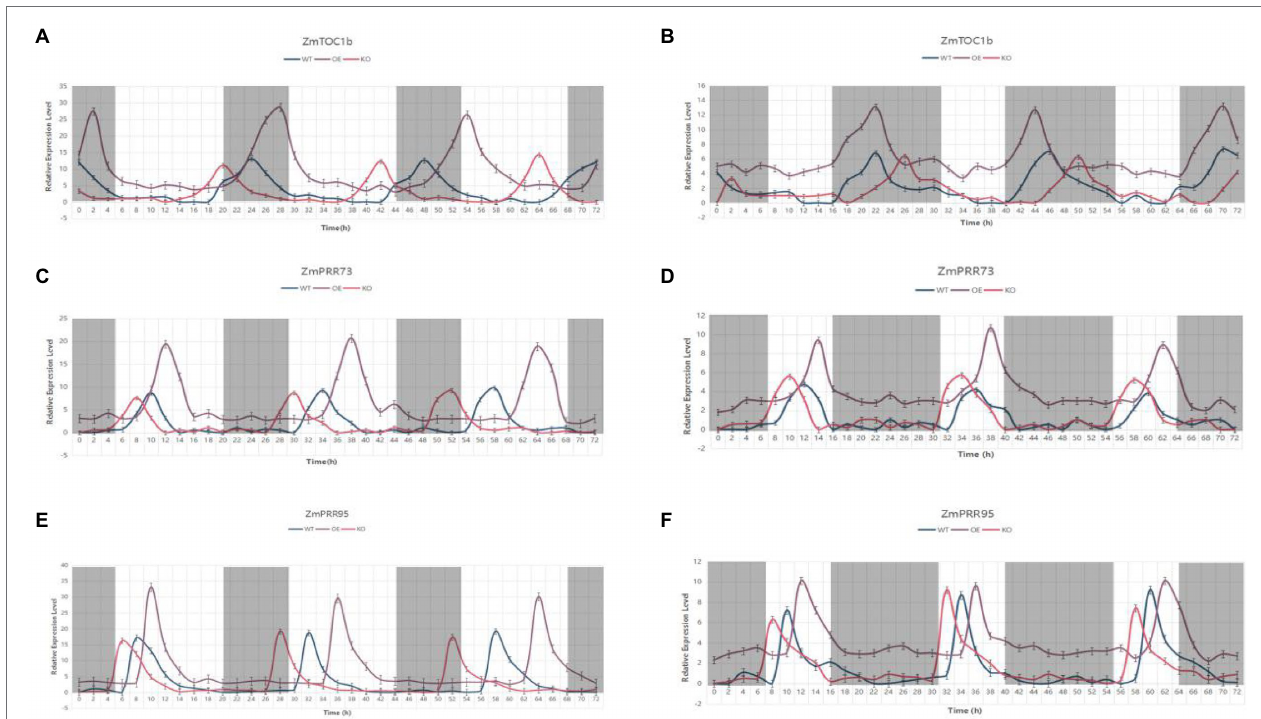
FIGURE 12 | The expression pattern analysis of the objective gene in transgenic positive plants and the WT under long-day and short-day light for 72 h. (A) Expression pattern analysis of ZmTOC1-positive plants and the WT under LD light. (B) Expression pattern analysis of ZmTOC1-positive plants and the WT under SD light. (C) Expression pattern analysis of ZmPRR73-positive plants and the WT under LD light. (D) Expression pattern analysis of ZmPRR73-positive plants and the WT under SD light. (E) Expression pattern analysis of ZmPRR95-positive plants and the WT under LD light. (F) Expression pattern analysis of ZmPRR95-positive plants and the WT under SD light. WTs are plotted in blue, objective gene overexpression-positive plants are plotted in violet, and objective gene knockout-positive plants are plotted in